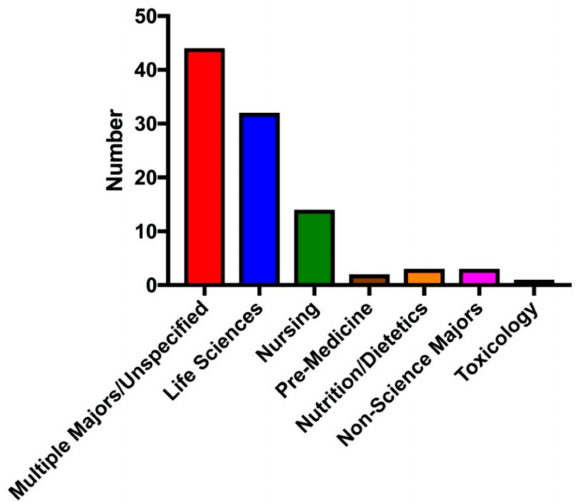
Figure 2. Targeted or reported college student major composition of undergraduate / graduate